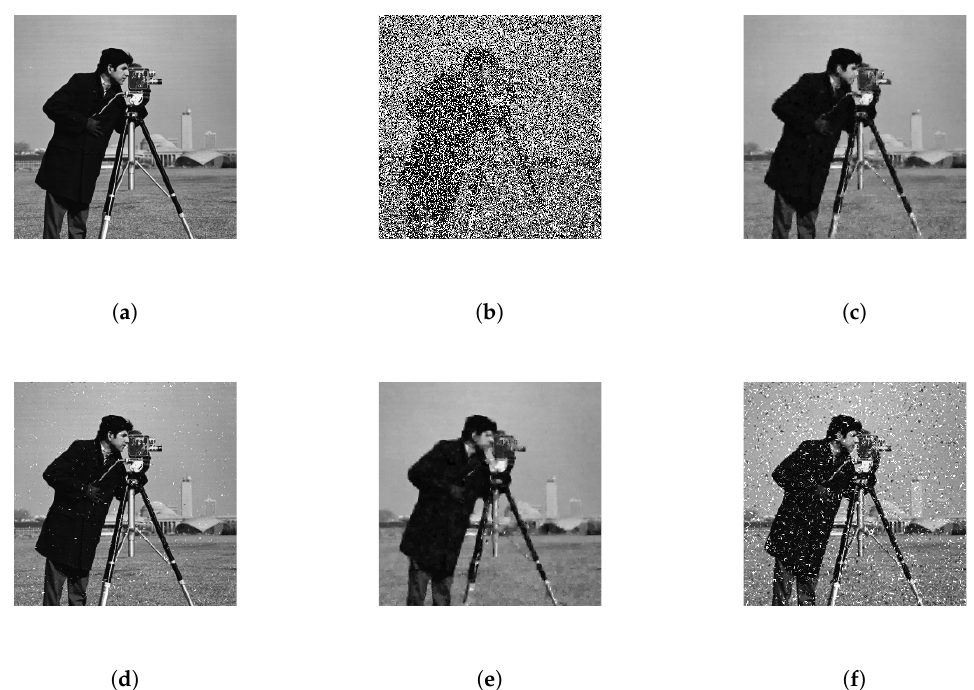
Figure 10. Restoration results of different algorithms under both salt-and-pepper noise and data missing for image Cameraman . ( a ) original image; ( b ) corrupted image with 40% salt-and pepper noise and 40% missing (7.03 dB); ( c ) reconstructed image obtained by framelet+APG (29.3 dB); ( d ) reconstructed image obtained by framelet+ADMM (26.4 dB); ( e ) reconstructed image obtained by wavelet+APG (26.1 dB); ( f ) reconstructed image obtained by wavelet+ADMM (24.7